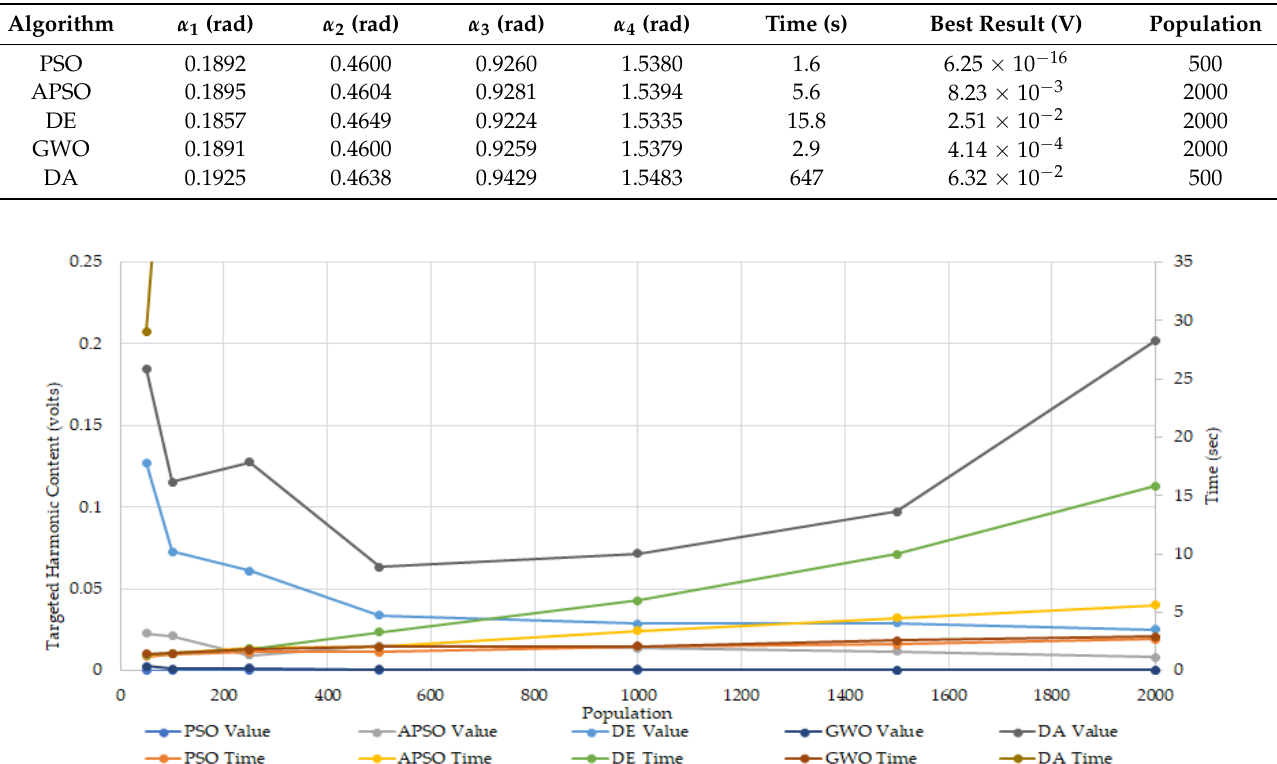
Figure 7. Summary of algorithms’ performance for a nine-level inverter.